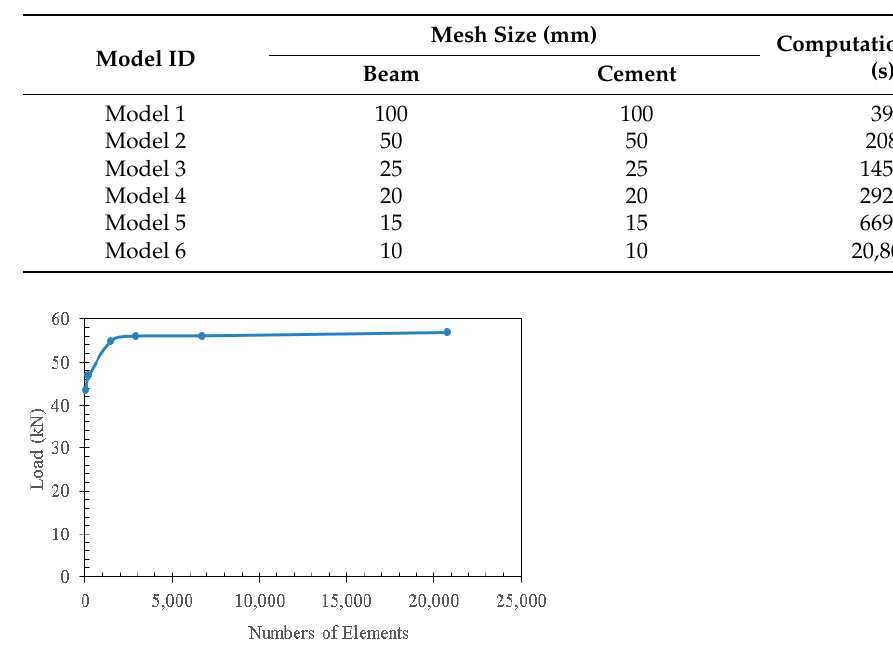
Figure 1. Comparison of the load-bearing capacity obtained from different mesh